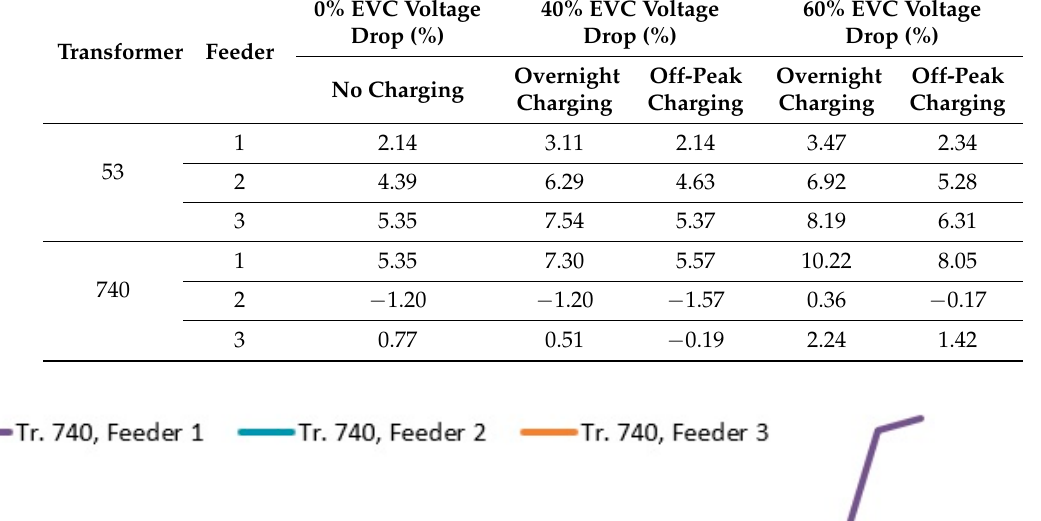
Table 8. Voltage drop at the end of the LV network in summer with 0%, 40%, and 60% EVC, and different charging schemes.